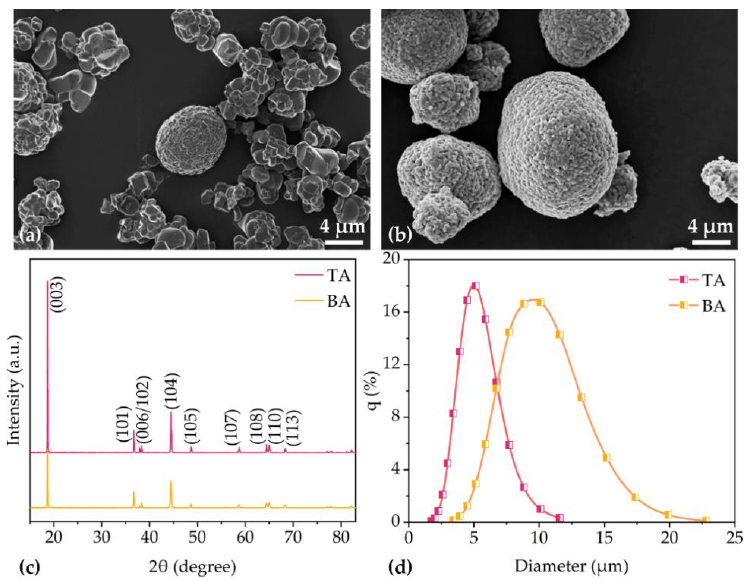
Figure 1. The SEM images of ( a ) TA NMC 622 particles and ( b ) BA NMC 622 particles. The ( c ) XRD patterns and ( d ) particle size distribution of two NMC 622 samples. The porosities of different cathodes decreased to 35% after calendering. The thicknesses of thin-film and thick-film electrodes are about 70 and 150 µm. The thickness ratios of TA and BA film inside hierarchical electrodes were set to 1:2, 1:1, and 2:1. The details of various cathodes are summarized in Table 1. Active mass loading is the mass of NMC 622 per unit area and areal capacity is calculated based on the mass loading. Table 1. The thickness, porosity, active mass loading, and areal capacity of electrodes consisted of different NMC 622 powder and with different multilayer structures. Cathode